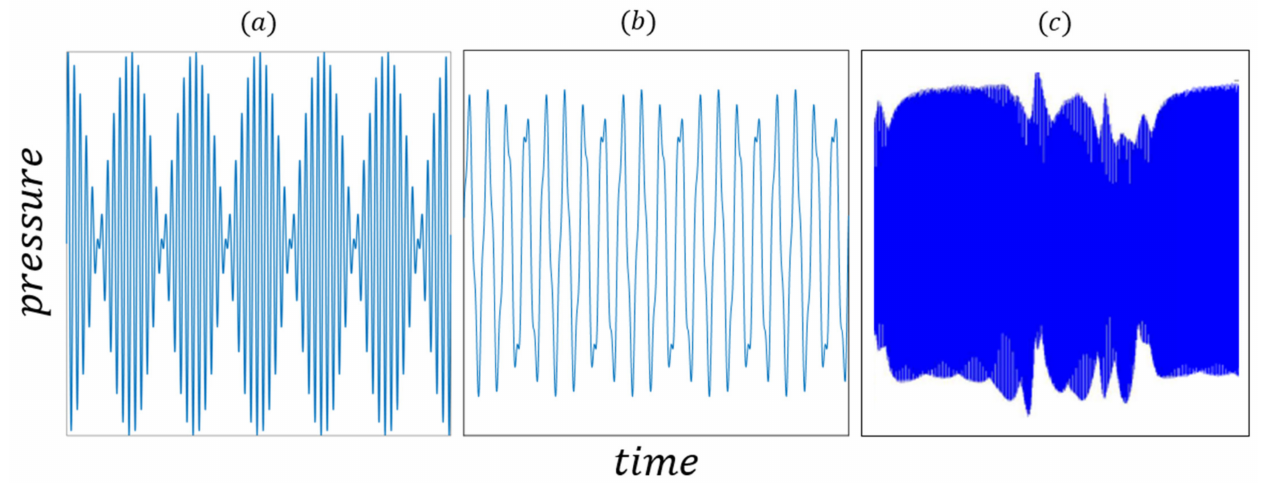
Figure 5. Beating ( a ), quasi-periodic oscillations ( b ) and chaotic oscillations ( c